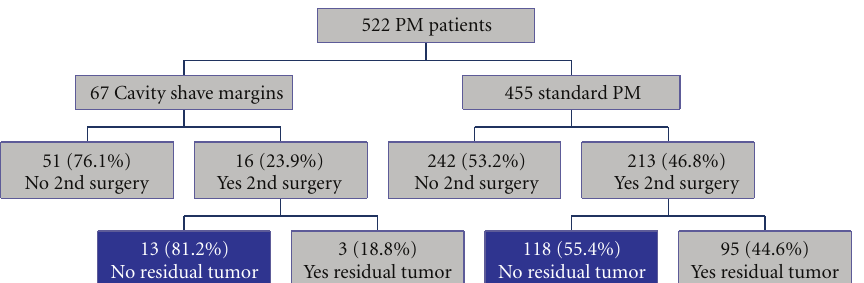
Figure 1: Reexcision rates of patients undergoing SPM versus CSM with analysis of residual tumor at